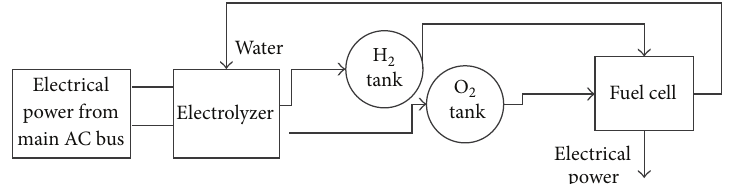
Figure 4: FC, hydrogen tank, oxygen tank, and electrolyser.